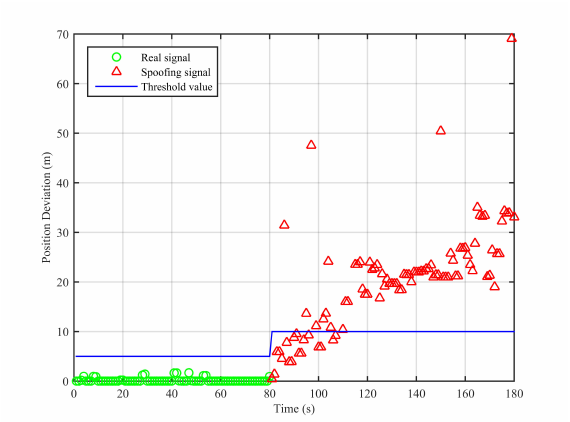
Figure 4. Position deviations of the two algorithms (Experiment No.